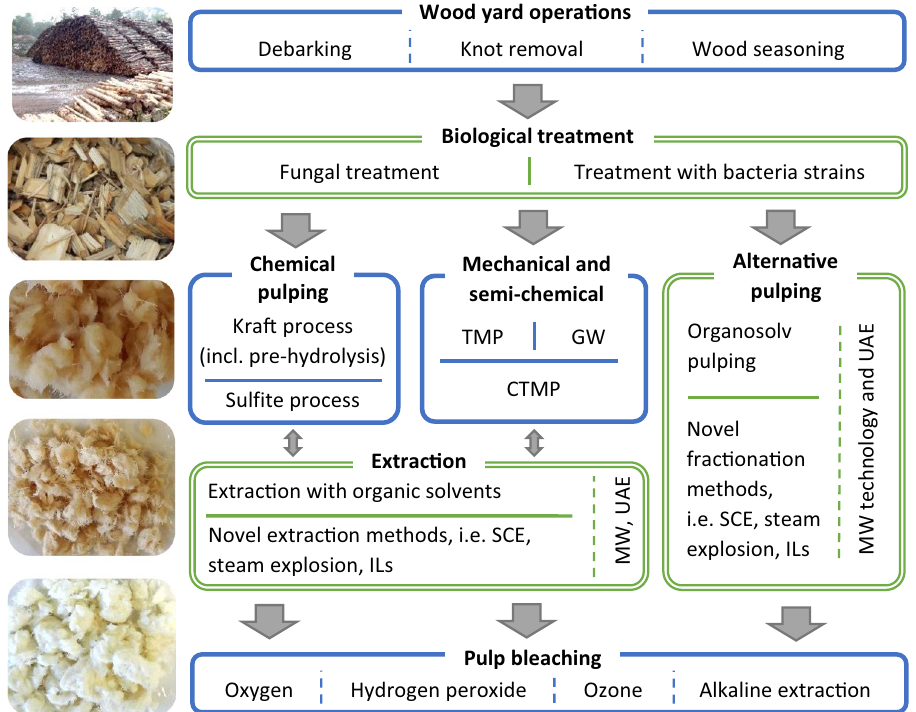
Fig. 1 Overview of established and alternative methods for removing wood extractives at pulp production. Descrip- tion : Blue solid-line frames are established conventional processes, green double-line frames are novel alternative methods. Solid lines inside the frames separate differ- ent options at the respective process stage; dashed lines indicate possible combinations of different